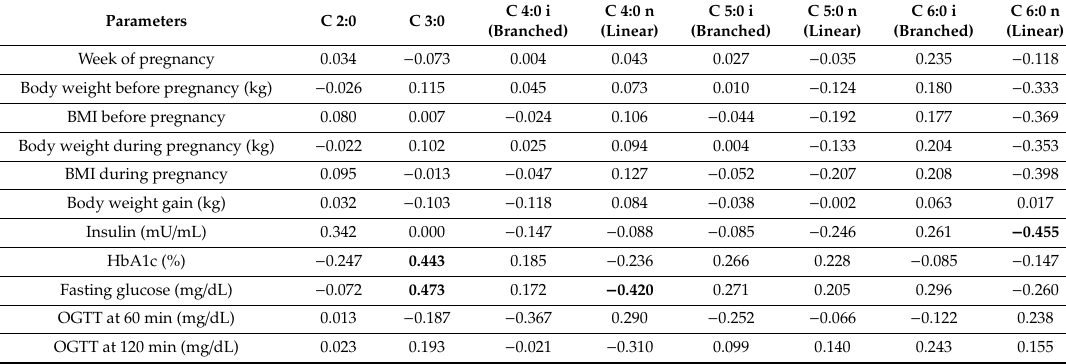
Table 3. Analysis of the relationship between SCFAs in the stool and the overall parameters in the groups of pregnant women.